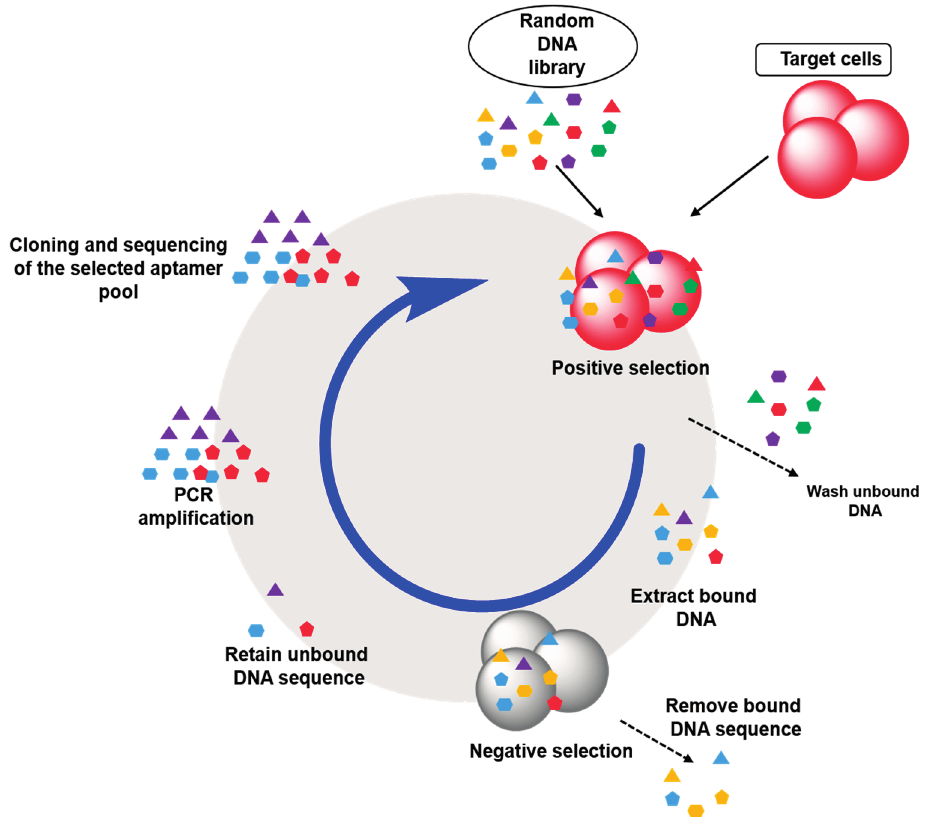
Figure 4. Scheme of cell-SELEX screening